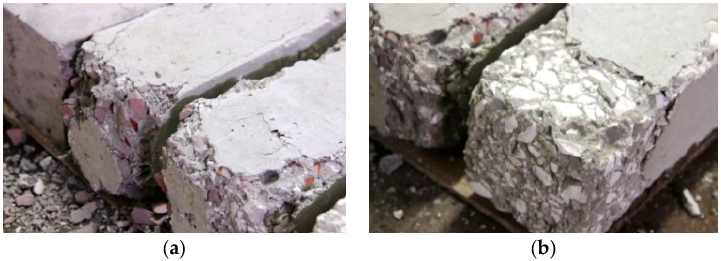
Figure 17. Examples of fire spalling of concrete surface after exposure to a temperature of 1000 °C for different concrete mixtures. ( a ) Concrete with CB and CT aggregates; ( b ) Mixture RM.